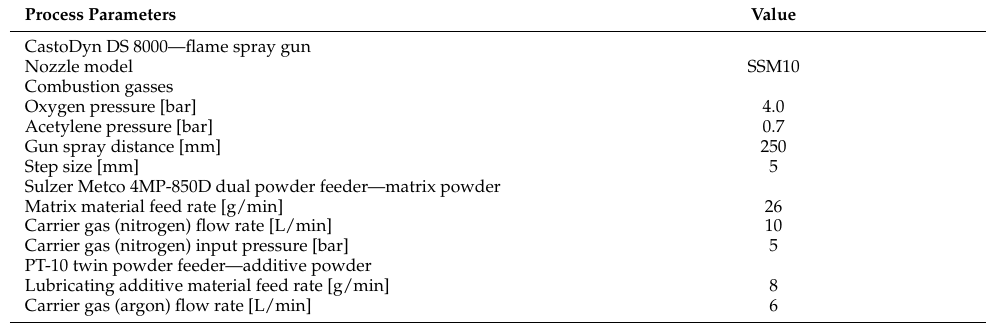
Table 1. Process parameters of the flame spray process with hybrid feedstock injection. Process